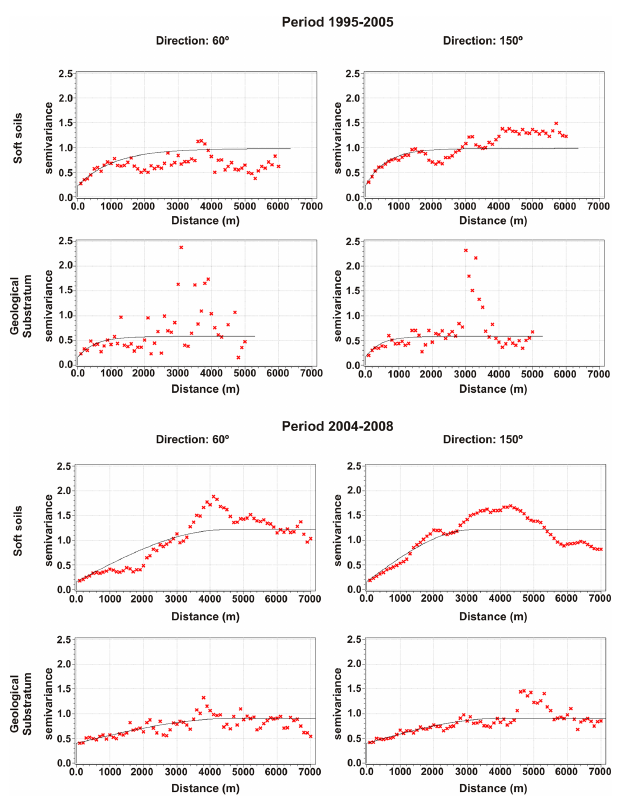
Figure 6. Experimental variograms with the fitted theoretical model in 60 and 150 ◦ directions (angles are counted from the north, in- creasing